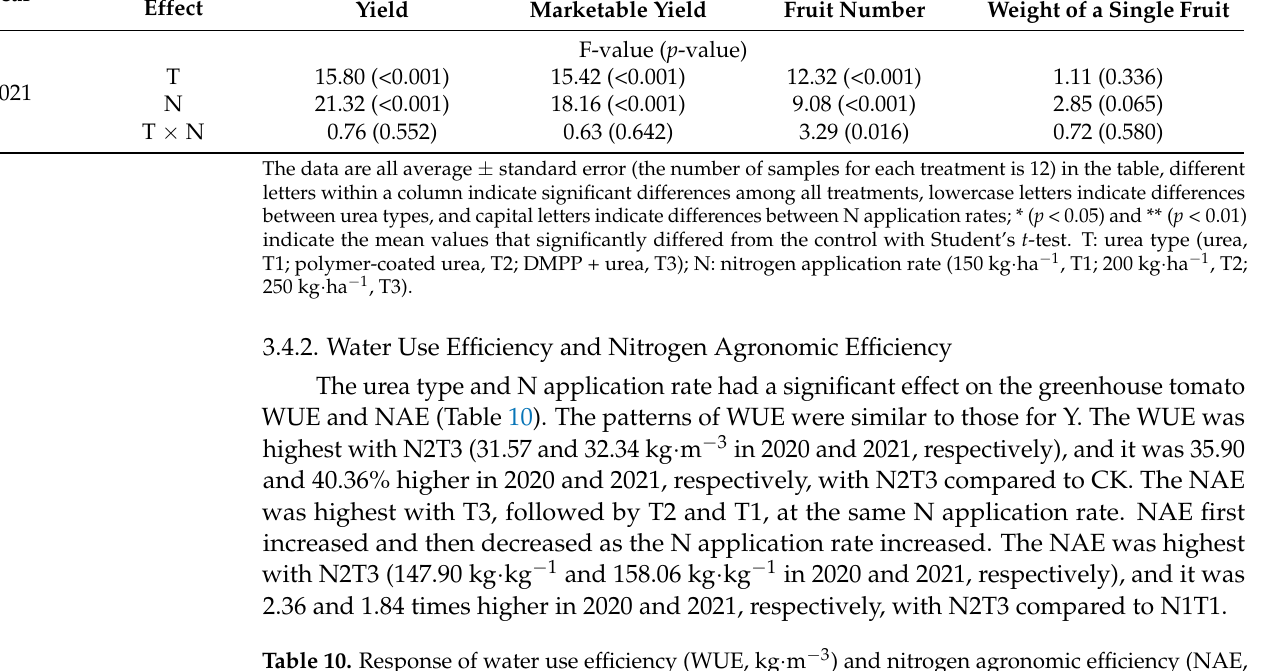
Table 10. Response of water use efficiency (WUE, kg · m − 3 ) and nitrogen agronomic efficiency (NAE, kg · kg − 1 ) of tomatoes to different urea types and N application rates in the